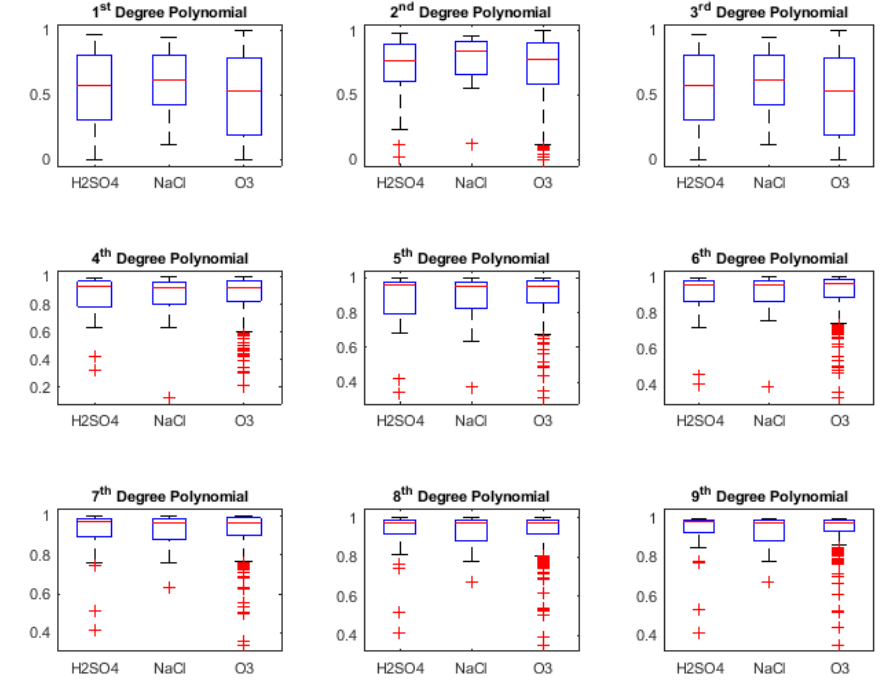
Figure 5. R-squared values for Polynomial curve fitting.